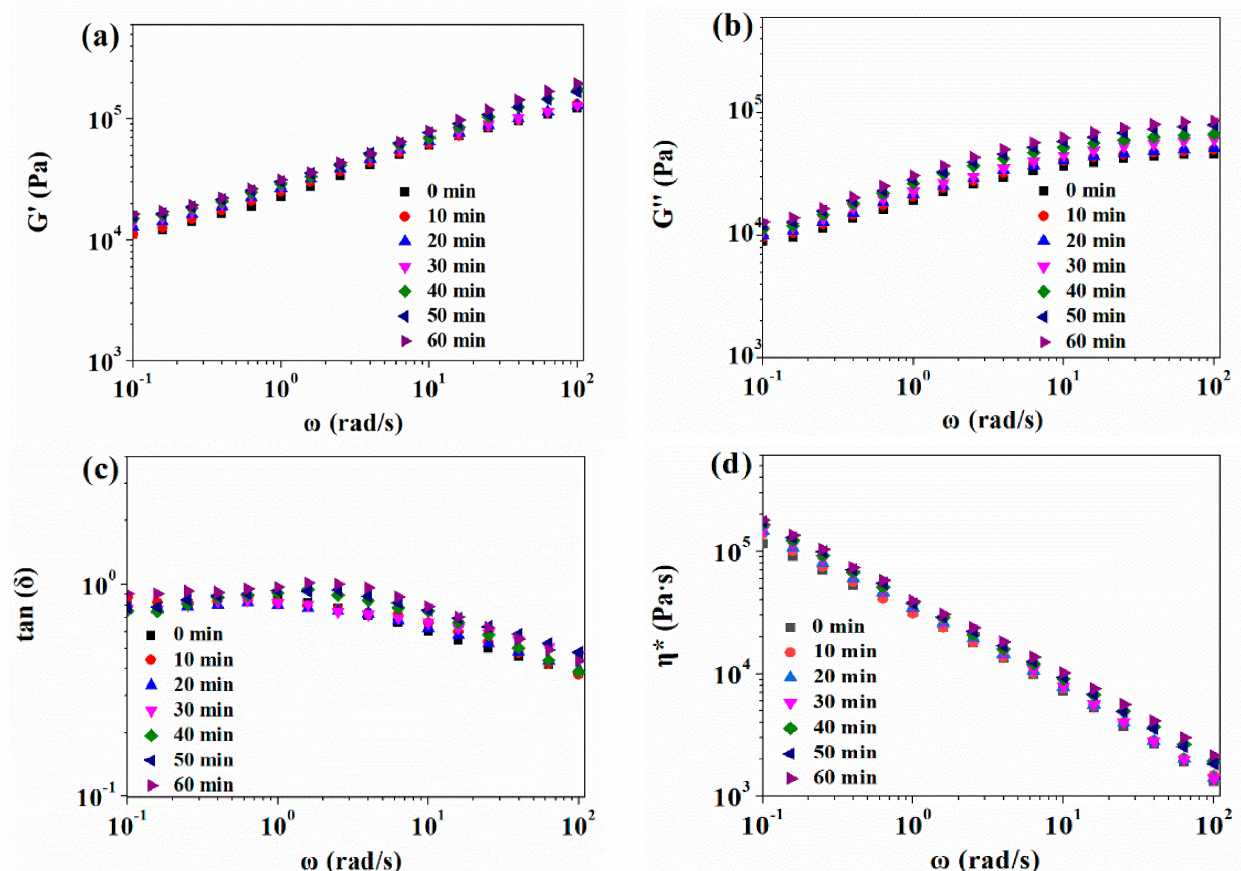
Figure 4. Rheological behavior of silicone rubber samples at different pre-vulcanization times at 35 ◦ C: ( a ) Storage modulus G (cid:48) ; ( b ) Loss modulus G” ; ( c ) Loss angle tan ( δ ); ( d ) Complex viscosity η *